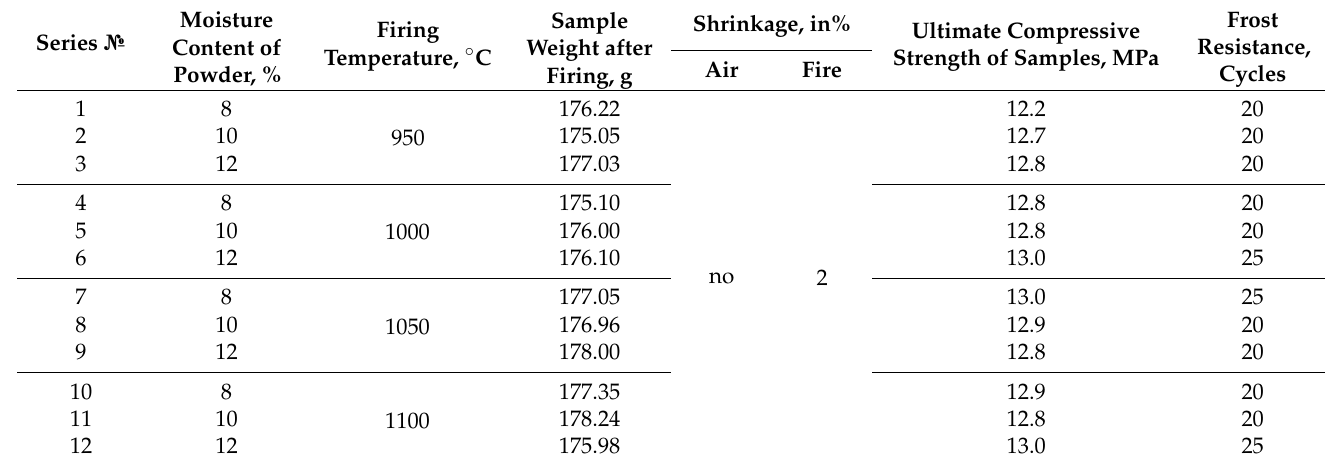
Table 6. Physical and mechanical properties of fired samples from clay material.